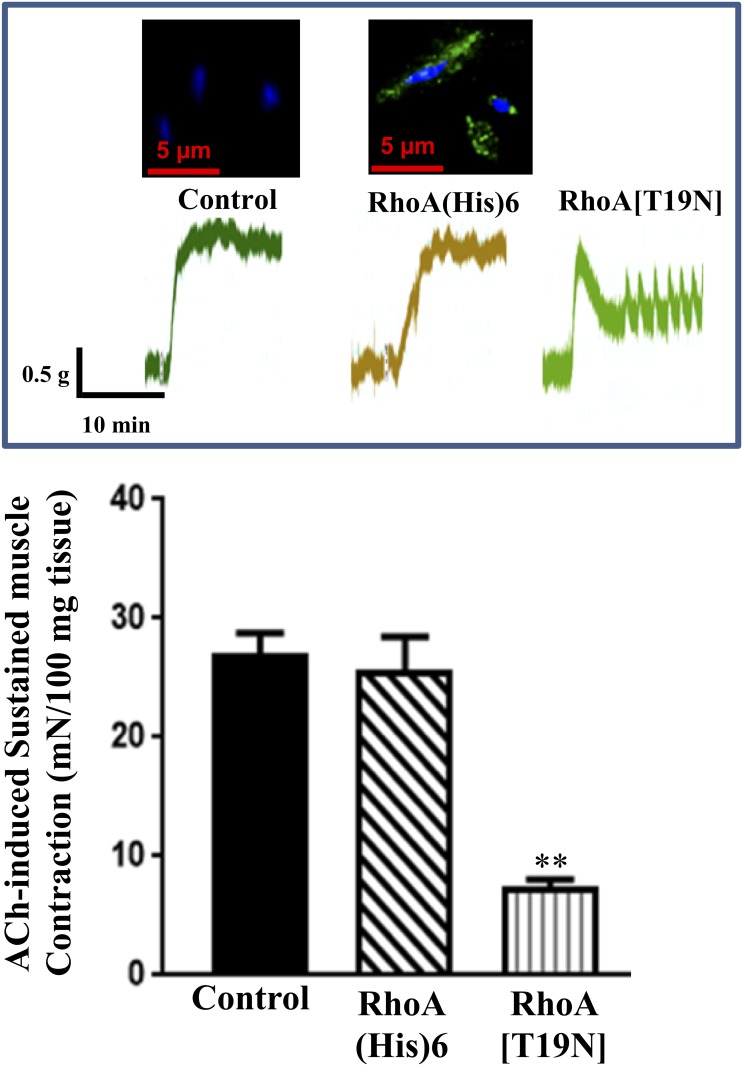
Inhibition of RhoA prevents ACh-induced sustained smooth muscle contraction in muscle strips.Muscle contraction was measured as increase in sustained contraction in response to acetylcholine (10 μM) in organ bath experiments in gastric smooth muscle of mice in the presence or absence of RhoA [His]6 or dominant-negative RhoA ([T19N]). Results are expressed as mN/100 mg of tissue. Traces and immunostaining of (His)6 are included in the graph. Values are means ± SE of 4–6 experiments. **P<0.001.